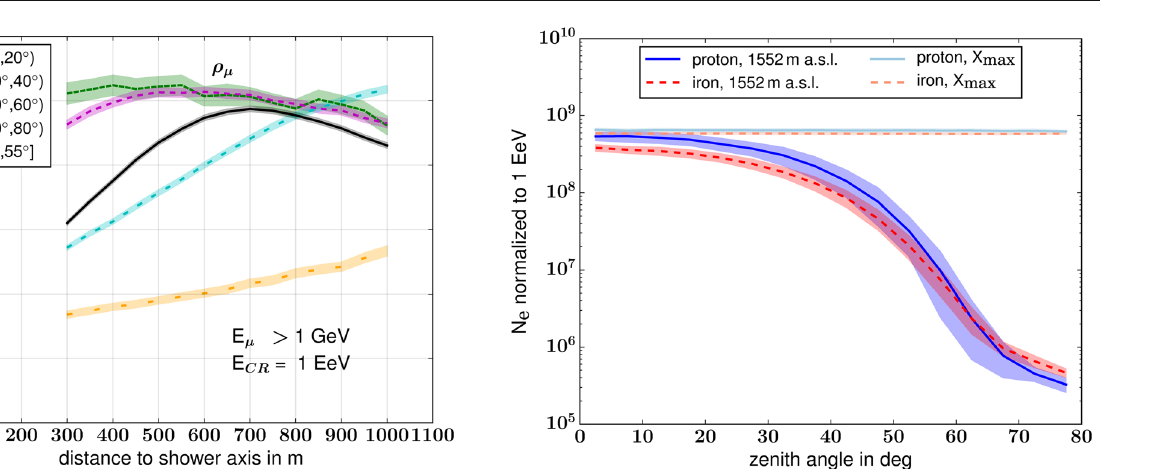
Fig. 6 Zenith angle dependence of the true number of electrons above anenergyof250keV.Thenumberofelectronsat1552ma.s.l.decreases by about three orders of magnitude over the plotted zenith angle range due to absorption in the atmosphere. Proton showers contain more elec- trons than iron showers except for very inclined showers, where the electrons are mainly products of muon decays. On the contrary, the number of electrons at X max is nearly independent of the zenith angle and higher in proton